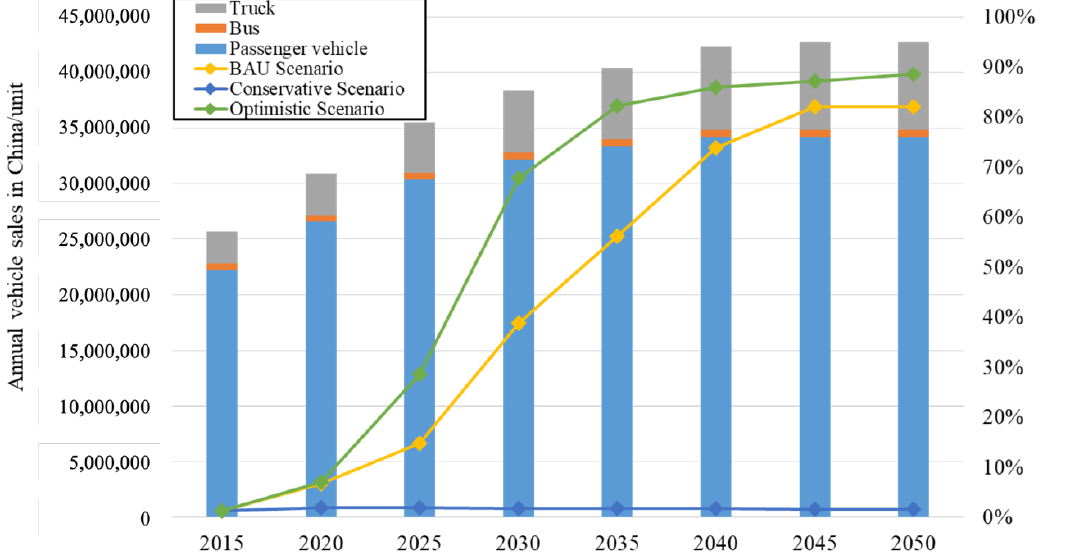
Figure 5. Different researches about electricity GHG emissions intensities.